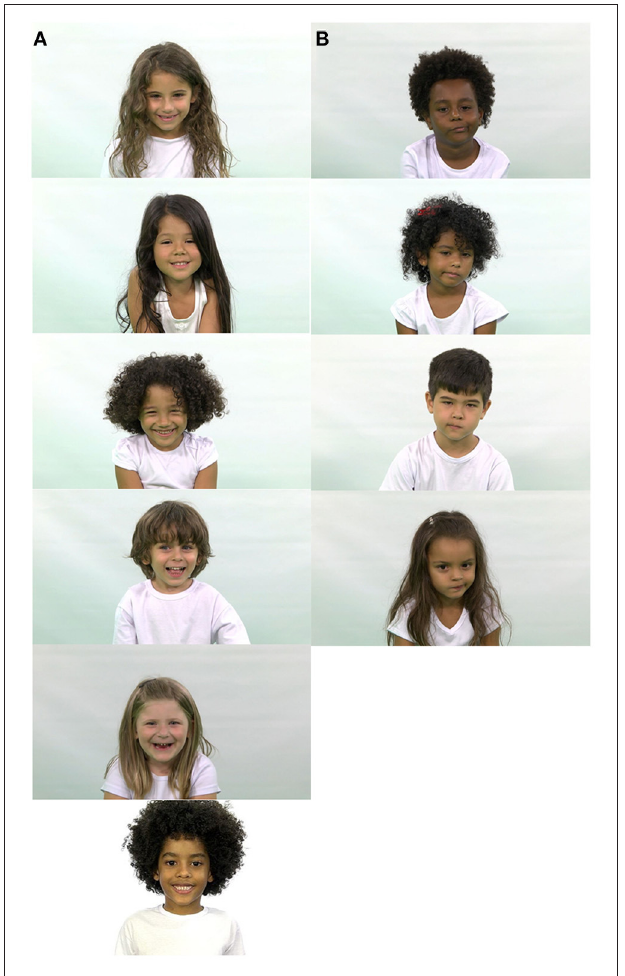
FIGURE 1 | Examples of ChildEFES database images. (A) Happiness (B) Contempt.